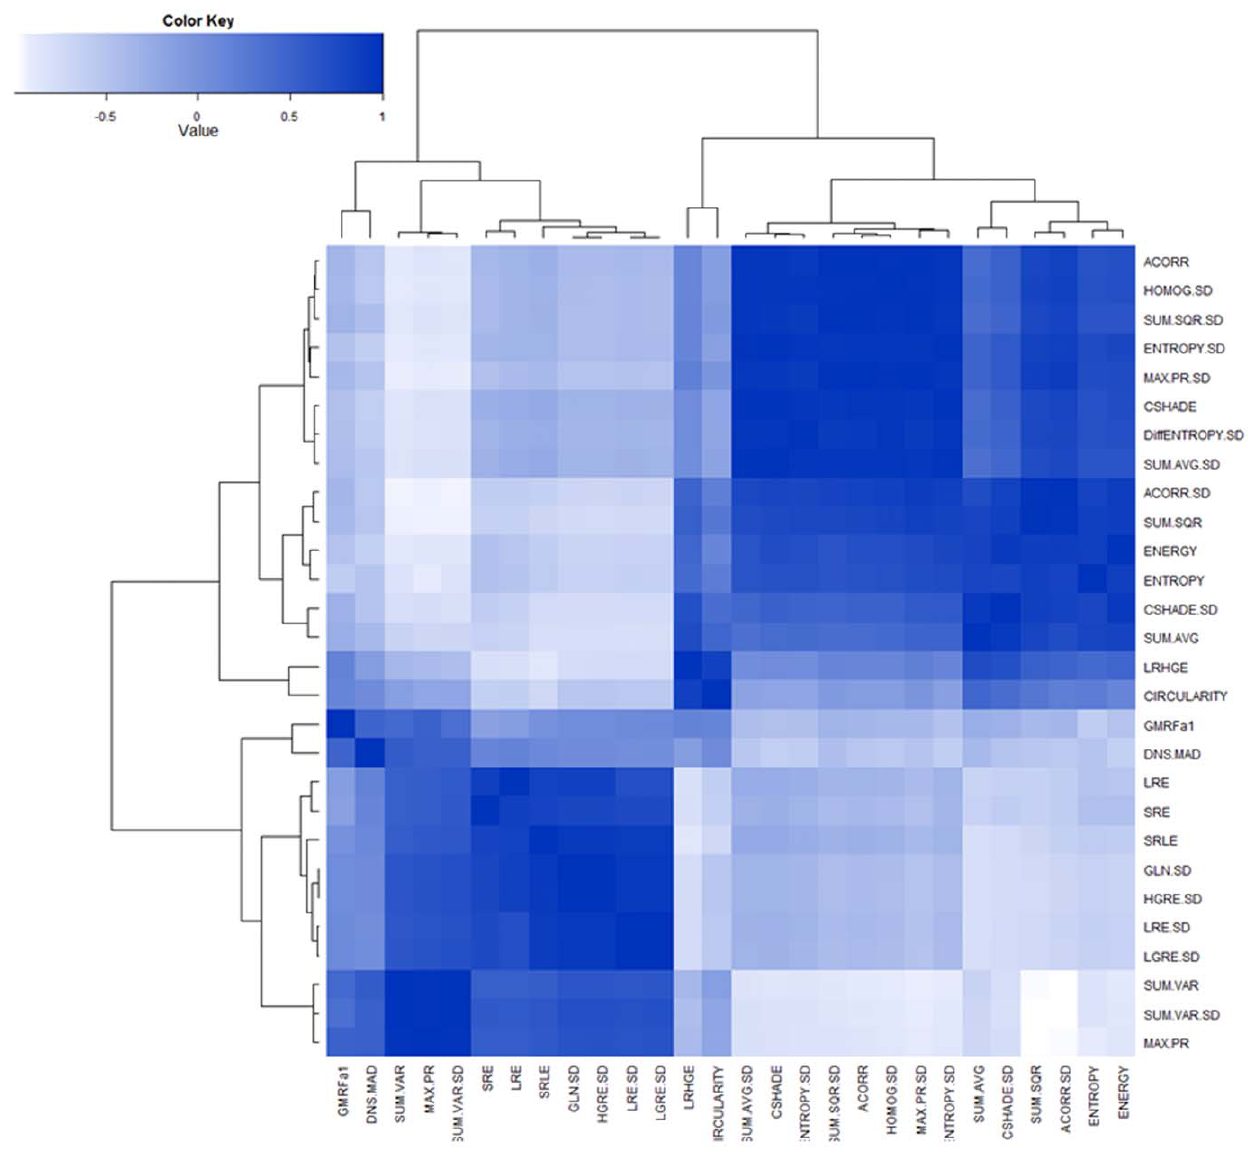
Figure 6. Correlation matrix is obtained using only the features, which have strong correlation with SUV max features. The resultant correlation values are used in hierarchical clustering algorithm to show the detail relationships of the feature sets. Again correlation values are running from R= 2 1 negative correlation (white) to R=1 positive correlation (blue).